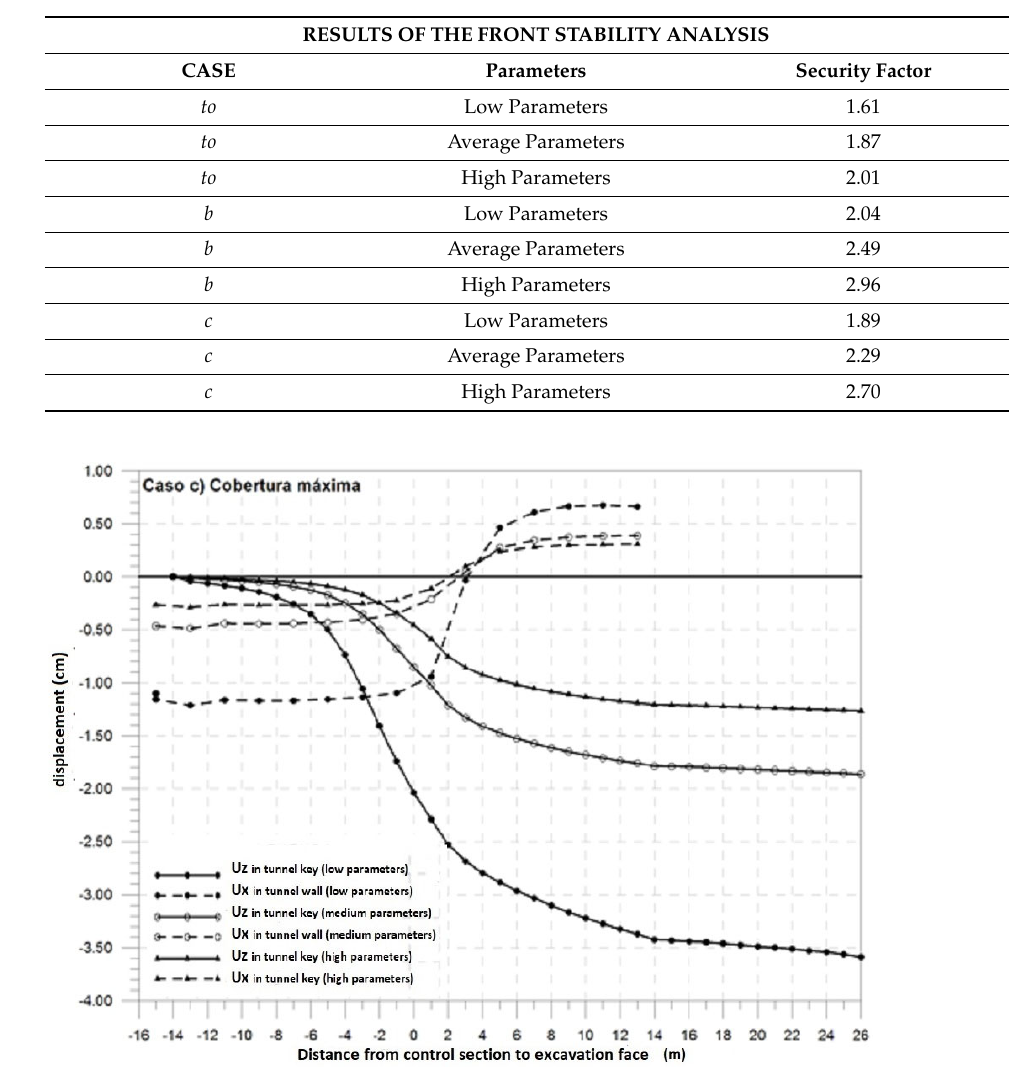
Figure 35. Evolution of the displacements in code (Uz) and gable (Ux) from excavation face.